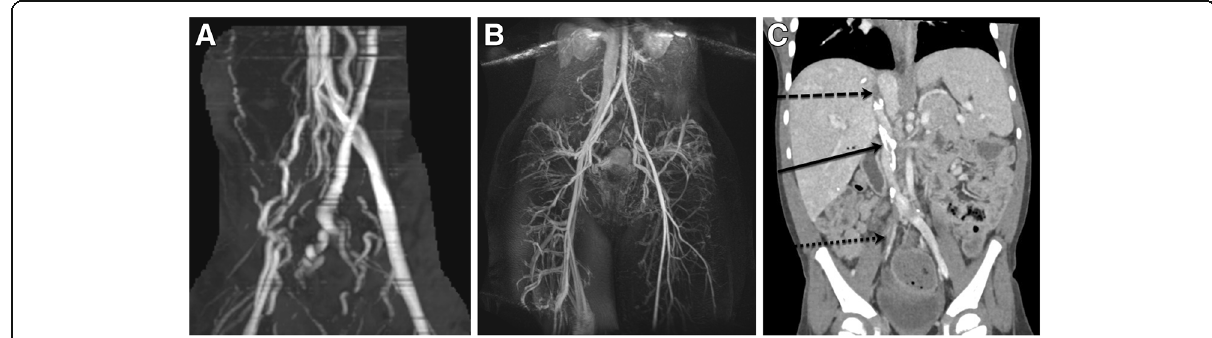
Fig. 2 a MRV of an 18 y/o M with chronic right lower extremity swelling and DVT demonstrates numerous venous collaterals but no central draining vein beyond the level of the iliac veins. This delayed, post-contrast MIP image shows the numerous venous collaterals in the pelvis and along the spine. b MRV of a 16 y/o F with acute onset of left lower extremity DVT shows patency of the right iliac veins draining into the IVC but no opacification of the left iliac veins. The overriding right common iliac artery compresses the left common iliac vein leading to the delayed venous drainage of the extremity and eventual thrombus formation. c CT of a 4 y/o M with chronic occlusion of the IVC (dashed arrow), multifocal calcified thrombi in the IVC (solid arrow), and fresh acute clot in the right common iliac vein (dotted arrow). A CT exam in this child allowed for an accurate, high resolution exam for deep venous recanalization planning without having to put the child under general anesthesia to obtain the